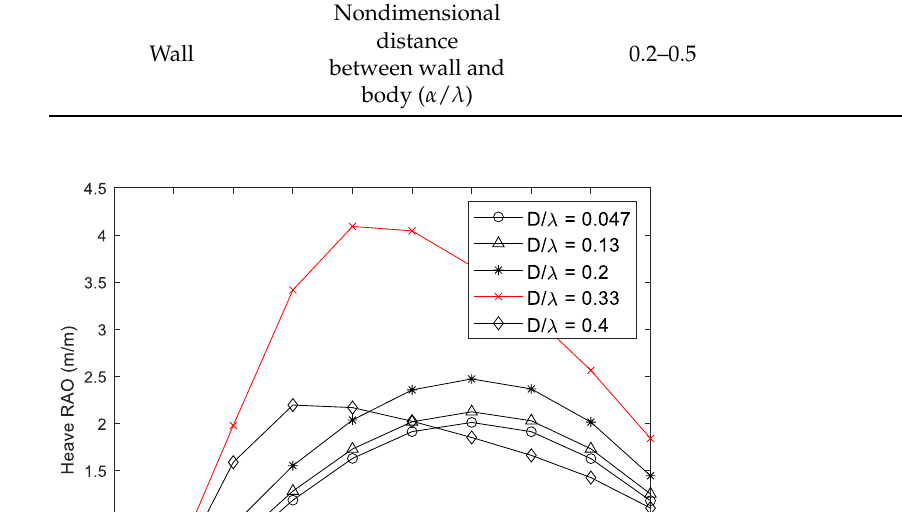
Table 3. Analysis conditions of a WEC integrated with a breakwater.